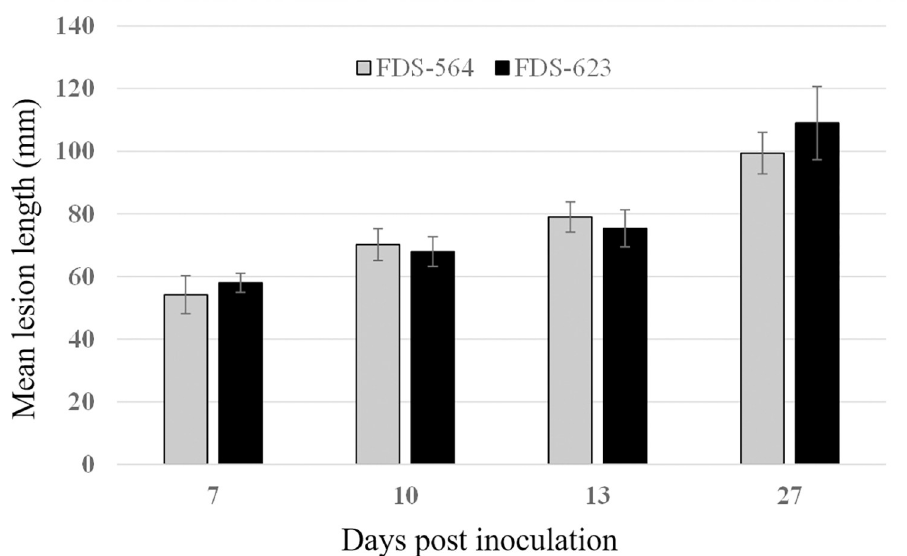
Fig 6. Mean lesion length caused by C . paraplurivora isolates FDS-564 and FDS-623 in Prunus persica var. persica seedlings 7, 10, 13 and 27 days post-inoculation.